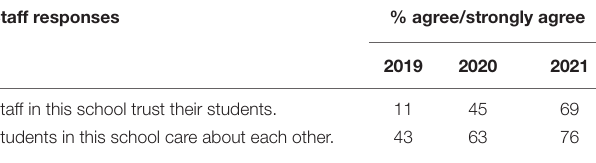
TABLE 6 | School staff surveys – staff trust in students. Staff